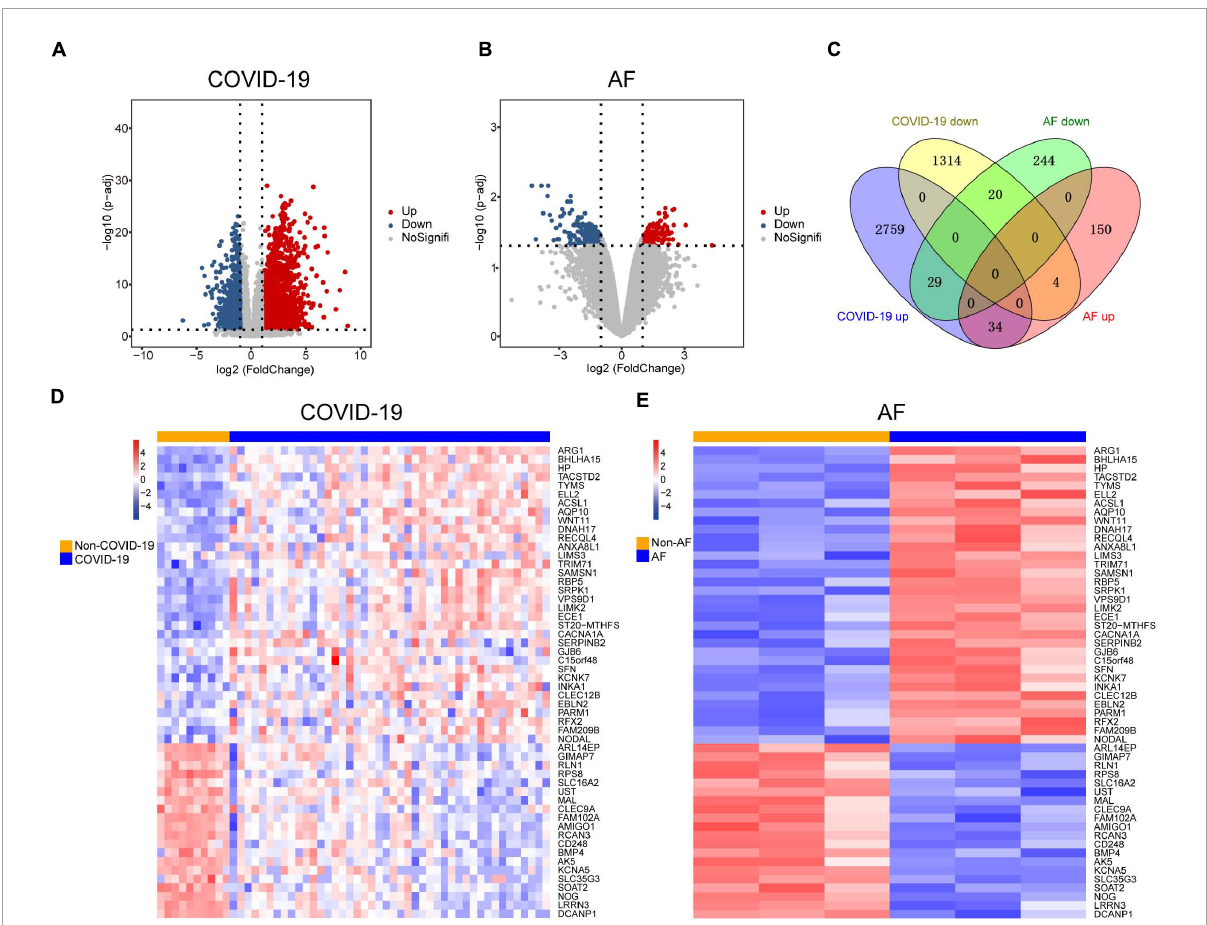
FIGURE2 Comparison of transcriptome analysis of peripheral blood transcriptome reveals common genes shared by COVID-19 patients and AF patients. (A) The red dots and blue dots of the volcano map show the DEGs expressing rising and falling in COVID-19 patients, respectively. (B) The red dots and blue dots of the volcano map show the DEGs expressing rising and falling in AF patients, respectively. (C) Venn diagram shows the number of shared genes of COVID-19 and AF. (D) Heat map of shared genes expression in COVID-19 patients. (E) Heat map of shared genes expression in AF